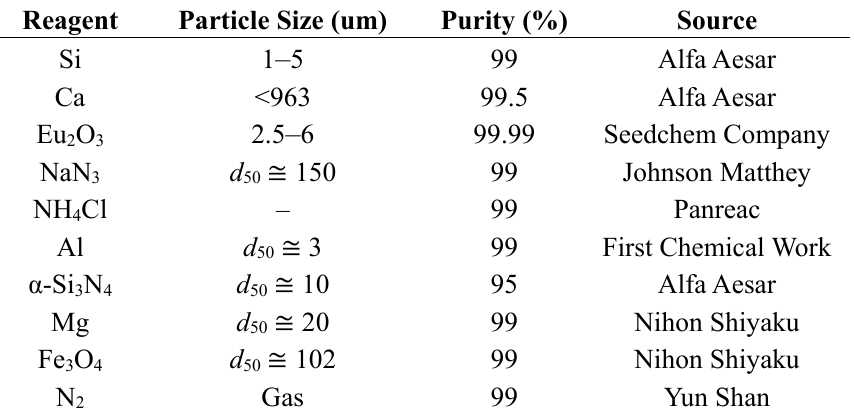
Table 1. Characteristics of the reagents used in this